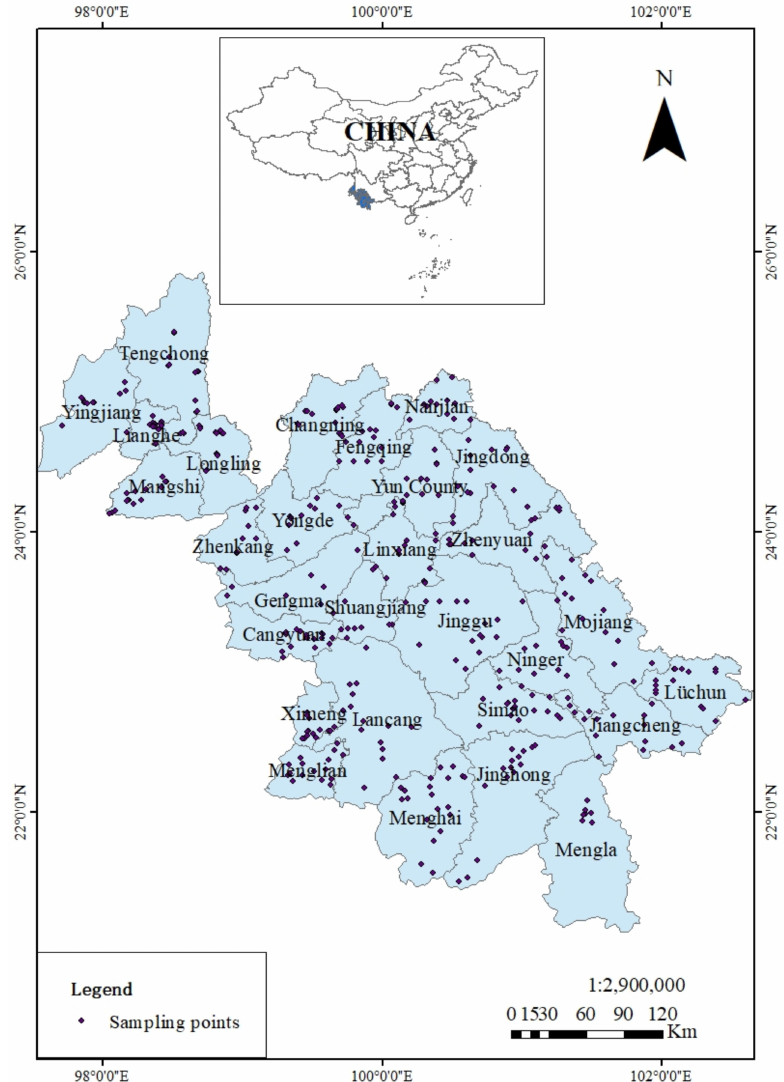
Figure 1. Map of the study area: the southwest region of Yunnan province,